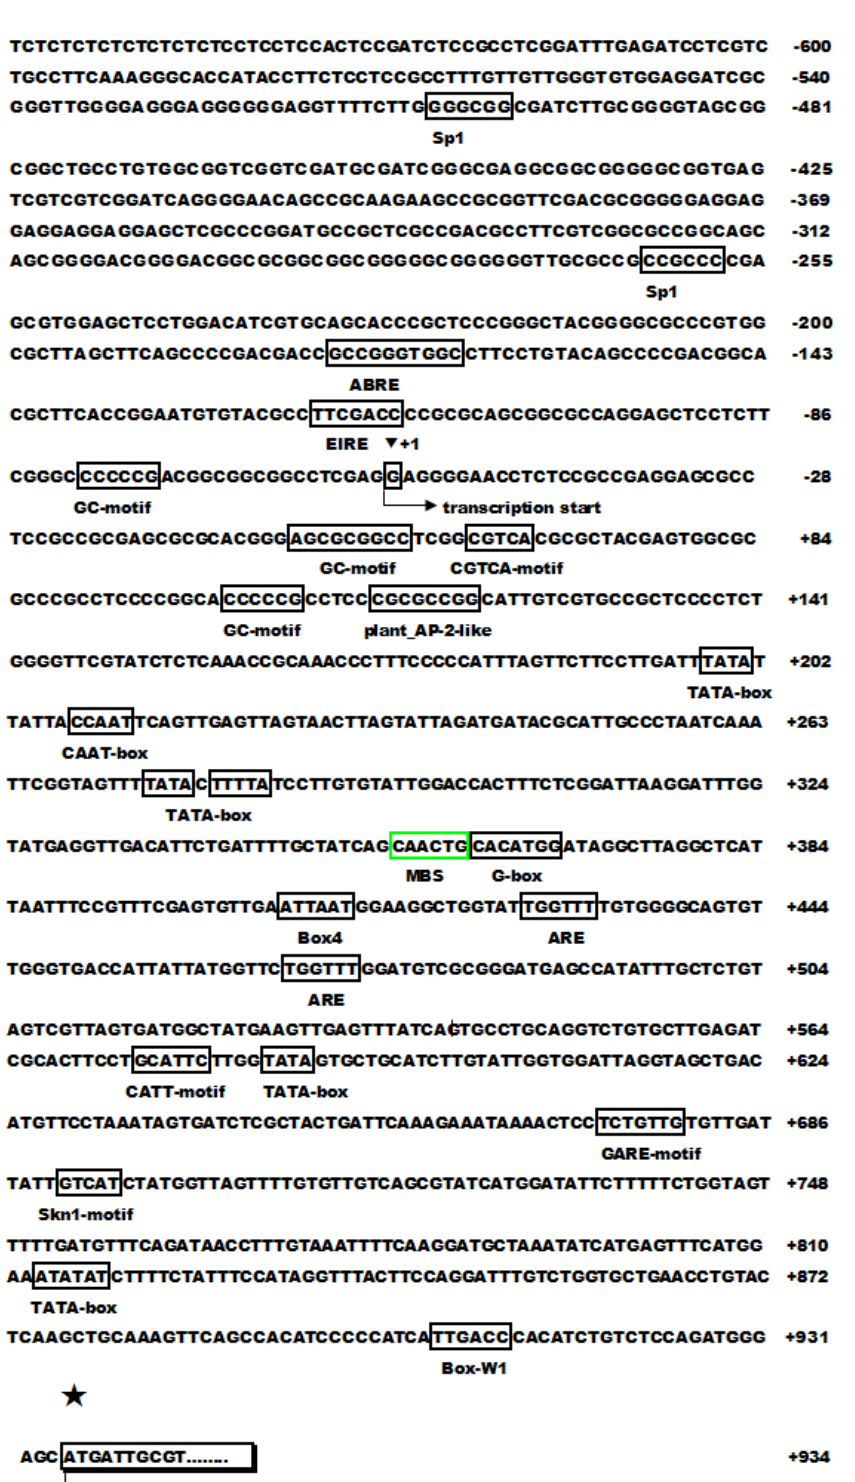
Figure 3. Promoter analysis of OsPOP5 . The putative cis -acting elements are boxed, and translation starts sites are indicated with arrows. Black inverted triangle (+1): transcription start. Black star: translation